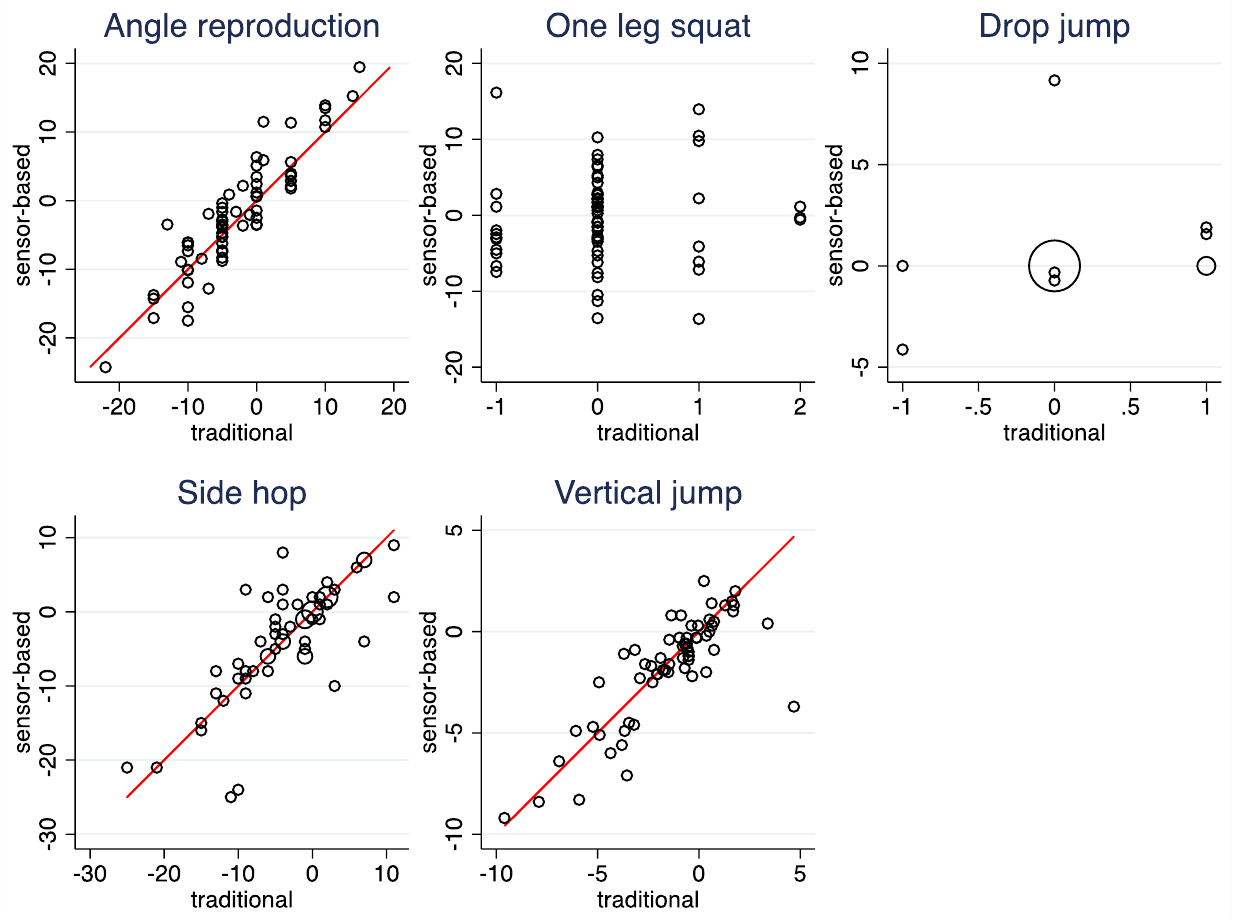
Figure 4. Scatterplots of the computed side differences comparing the sensor-based and the traditional assessment. The area of the circles is proportional to the number of observations. The line indicates equality of the two computed values.